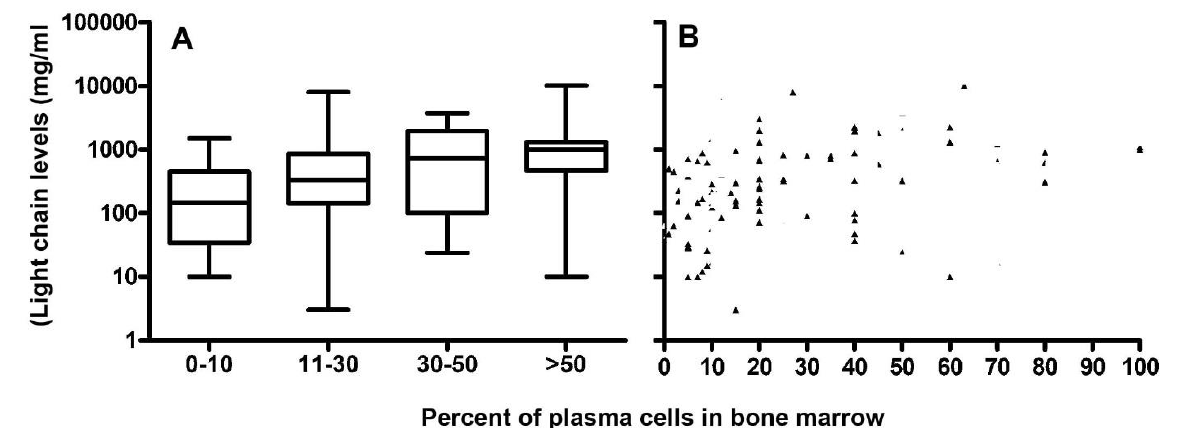
Figure 1. AL patients’ plasma cell content within the bone marrow in correlation to the serum free light chain levels at diagnosis. ( A ). Bar plot correlating plasma cells percentage clustered (10%< and >50% p = 0.001). ( B ). Dot plot correlating plasma cells percentage with free light chain levels (Pearson r = 0.225. p = 0.07).